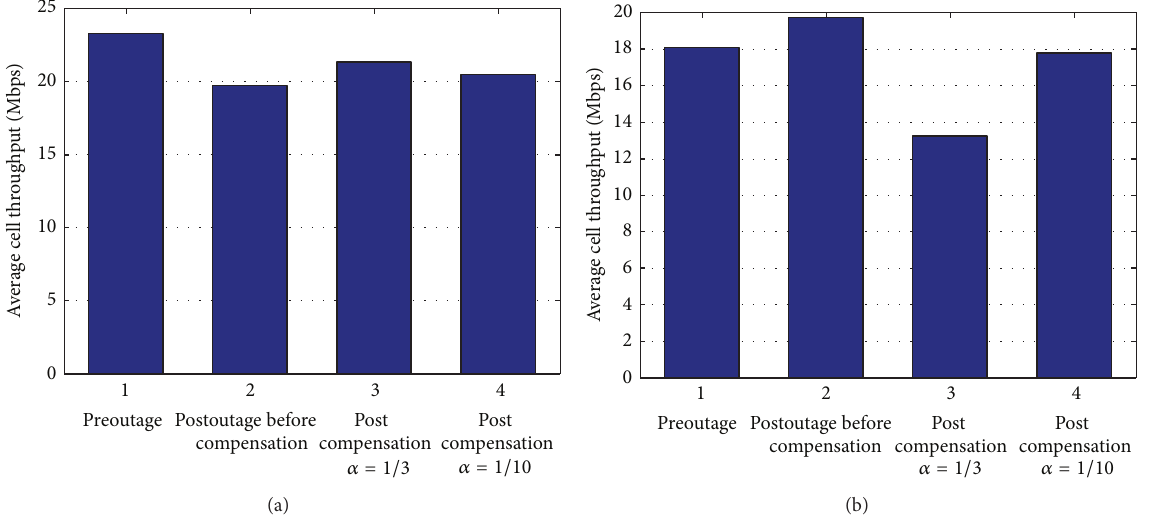
Figure 7: Average cell throughput with respect to different system states: (a) users in the outage area and (b) users in the surrounding